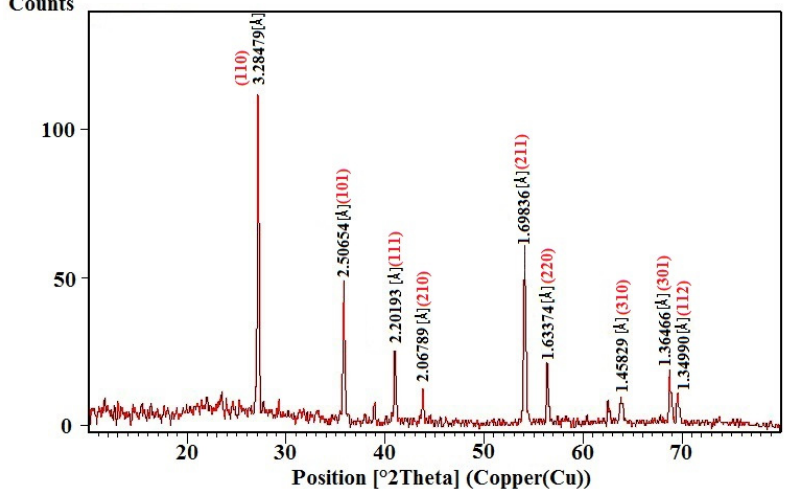
Figure 5. X-ray diffraction spectroscopic analysis (XRD) of the biosynthesized TiO 2 NPs.